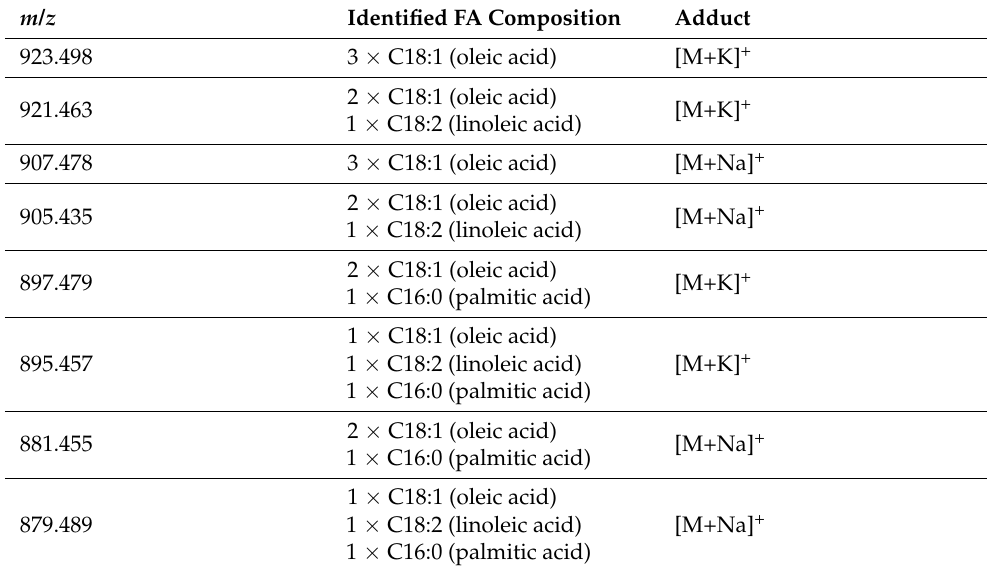
Table 1. Composition in fatty acids, determined by MS/MS experiments, of the triglycerides adducts detected for the analysis of an olive oil sample by